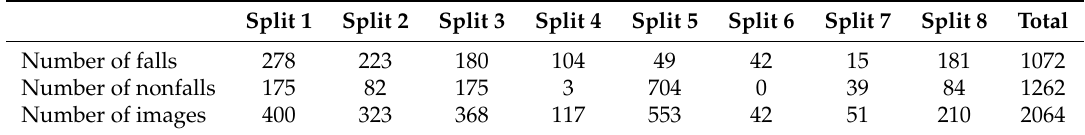
Figure 10. Ground-truth image examples of the FPDS. Each row belongs to a different split. Bounding boxes are red/green in case of fall/nonfall detection. Table 2. FPDS dataset